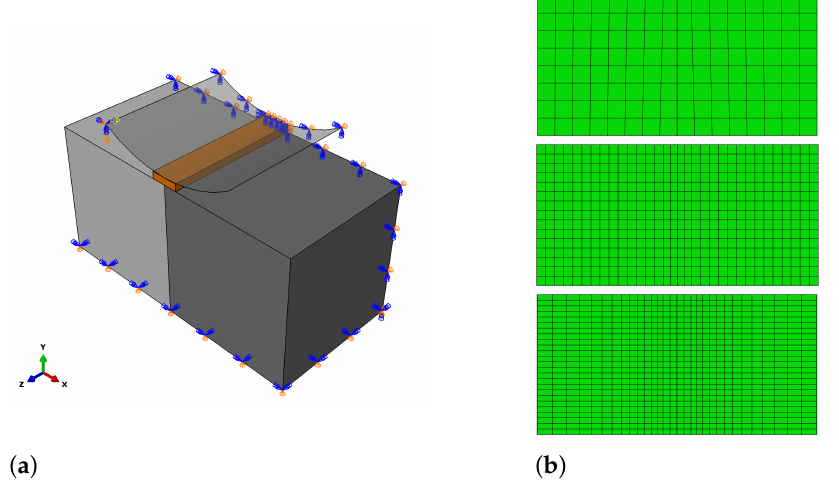
Figure 13. ( a ) Model of the splitting test. ( b ) Meshes adopted in the analyses (from the top): 10 mm, 5 mm, and 2